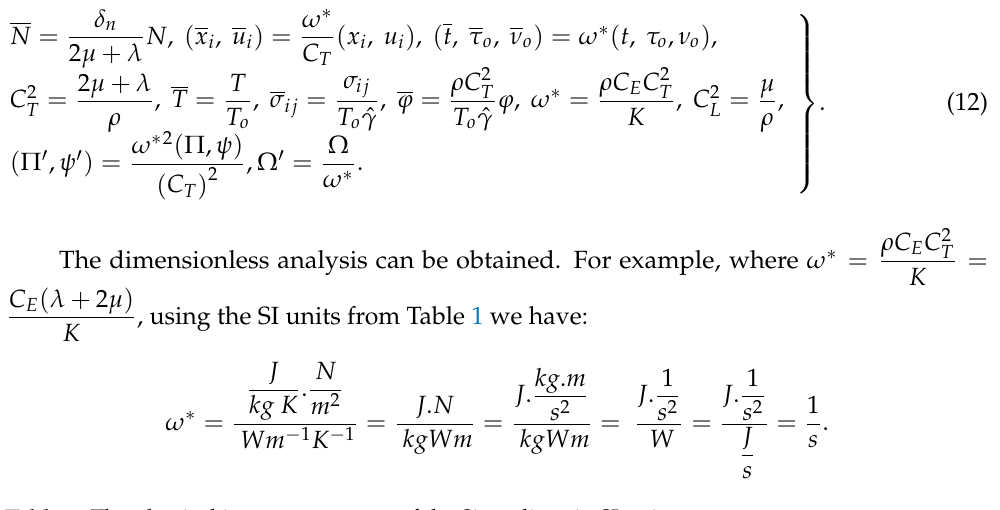
Table 1. The physical input parameters of the Si medium in SI units. Unit